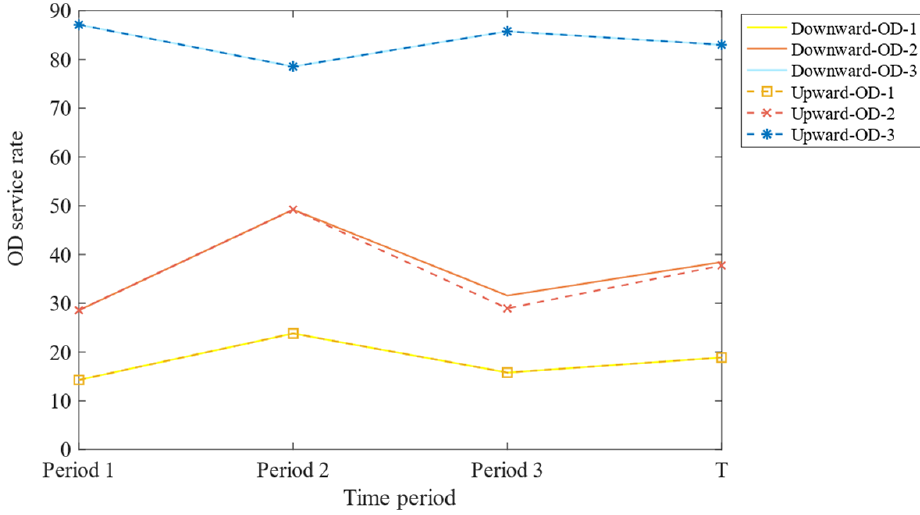
Figure 9. OD serve rates in upward and downward directions.